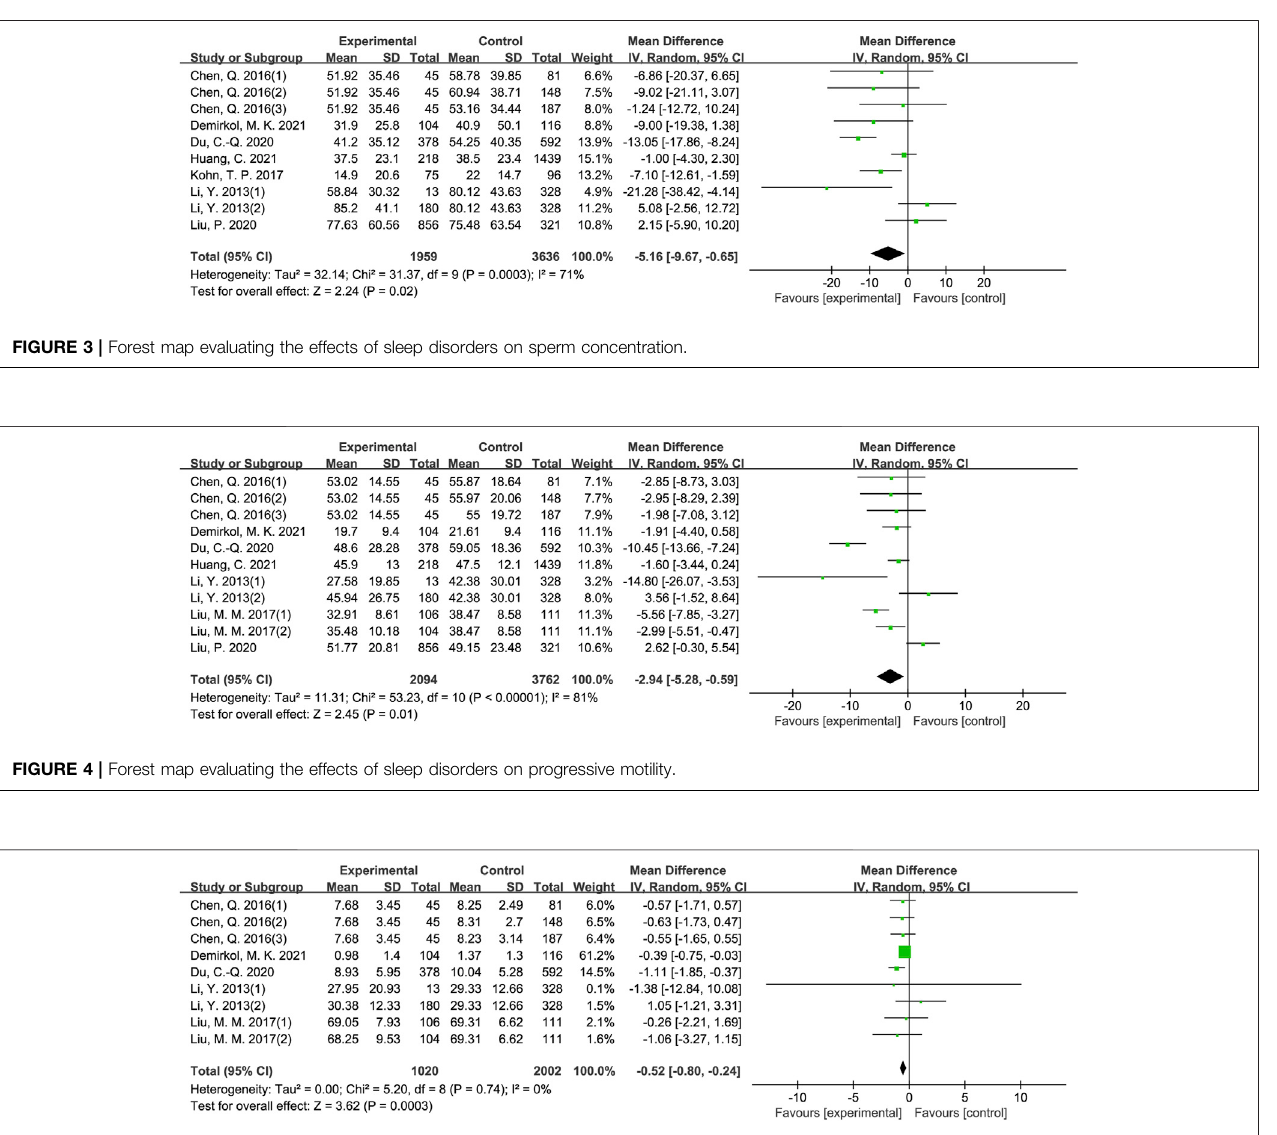
FIGURE 5 | Forest map evaluating the effects of sleep disorders on normal morphology.